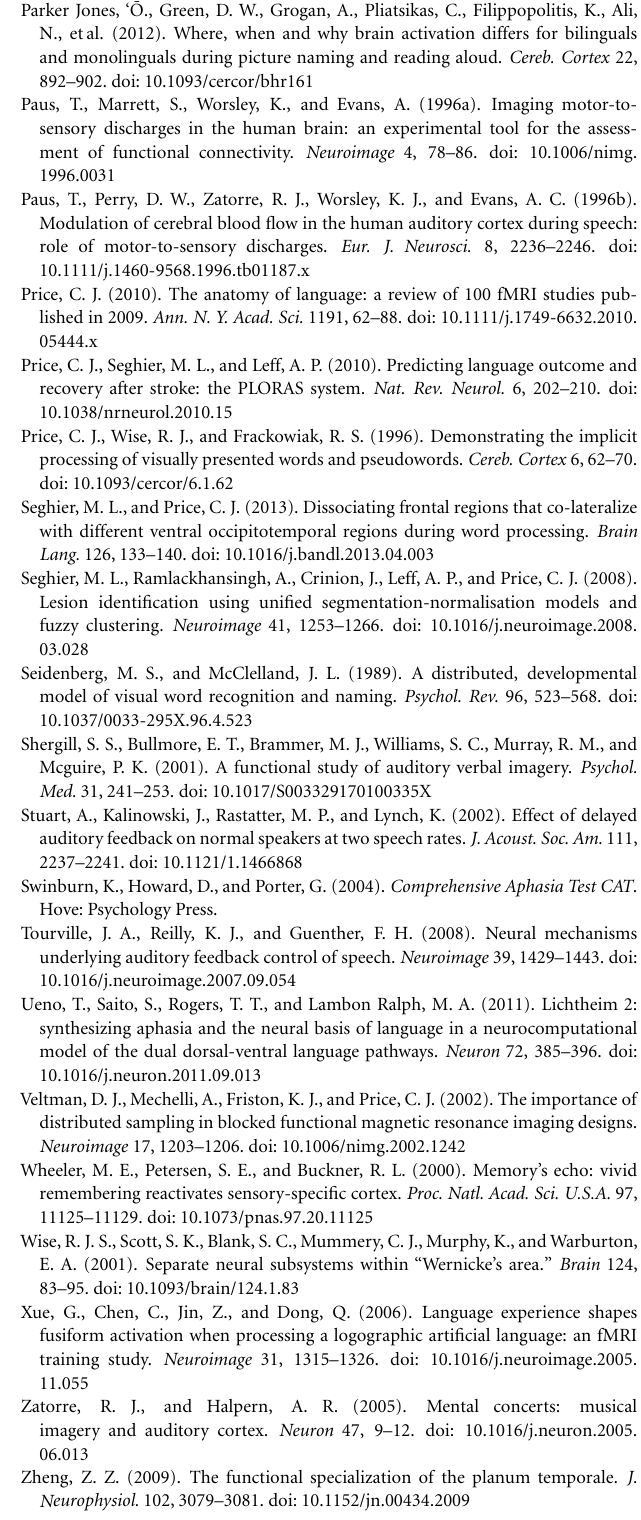
ConflictofInterestStatement: Theauthorsdeclarethattheresearchwasconducted in the absence of any commercial or financial relationships that could be construed as a potential conflict of